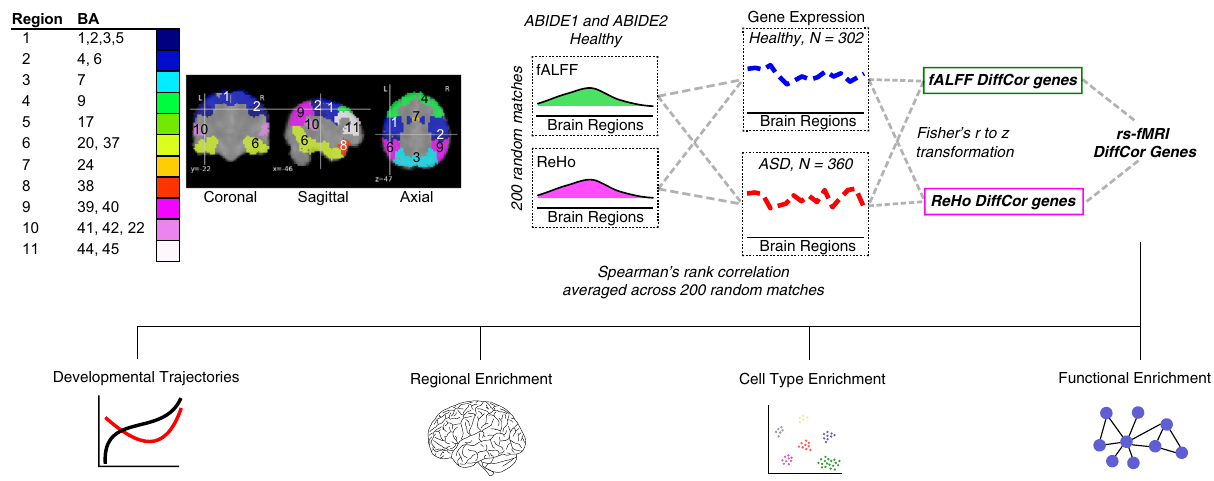
Fig. 1 Flowchart of the analytical framework and pipeline. Gene expression values were obtained for 11 cortical regions from individuals diagnosed with autism spectrum disorder (ASD) and demographically matched neurotypical individuals (CTL: control). For fMRI, the ABIDE I and II datasets were used to select ASD and CTL individuals that demographically matched with the gene expression cohort. Regional Homogeneity (ReHo) and fractional amplitude of low frequency oscillations (fALFF) were calculated from these individuals for the 11 cortical regions. 200 subsampled matches were selected from CTL individuals. Spearman ’ s rank correlation was used to infer a correlation between gene expression and fMRI separately for both fMRI measurements. For differential correlation (DC genes) between ASD and CTL, the mean correlation values of matches were transformed to a z score (Fisher ’ s r to z transformation) and statistics combined (Fisher ’ s combined method). A gene was called differentially correlated if the differential correlation p -value was less than 0.01 (DiffCorP < 0.01) and FDR < 0.05 in CTL. The fi nal list consisted of genes that are differentially correlated using both fMRI